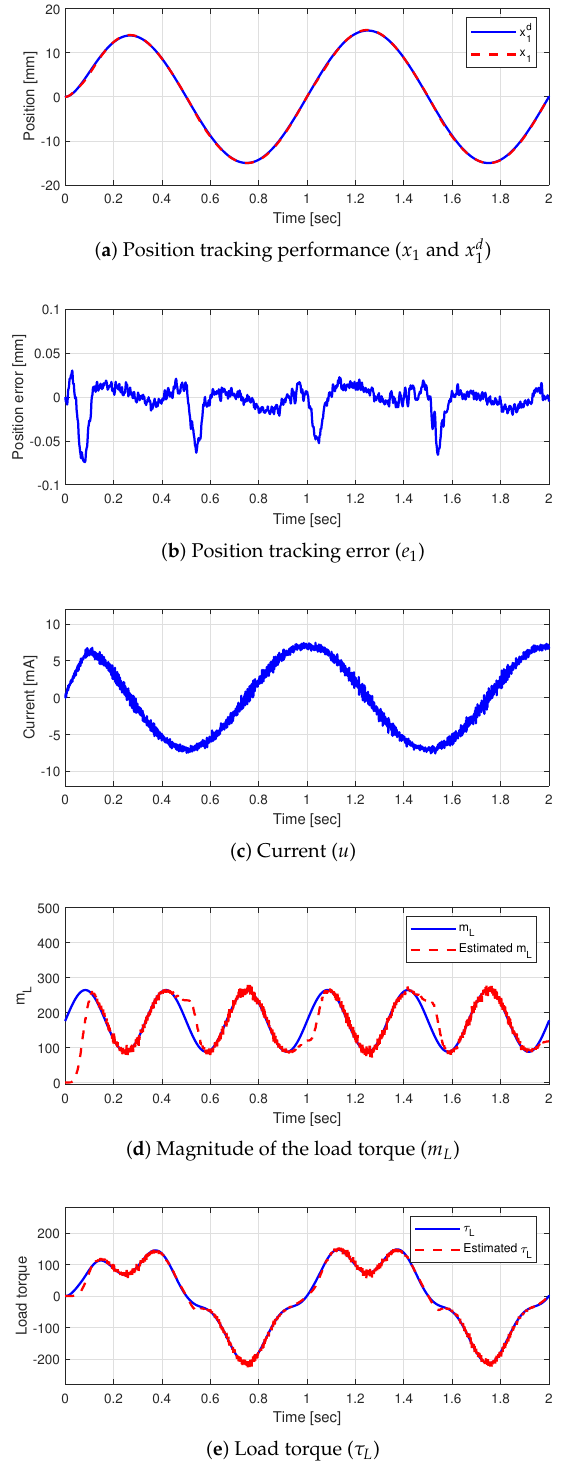
Figure 5. Simulation results for Case 2: position tracking performance ( x 1 and x d error ( e 1 ) ( b ), current ( u ) ( c ), magnitude of the load torque ( m L ) ( d ) and Load torque ( τ L ) ( e